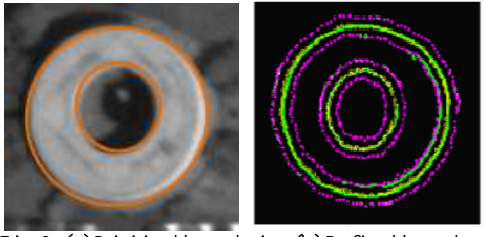
Fig. 3: (a) Digitized boundaries, (b) Refined boundary